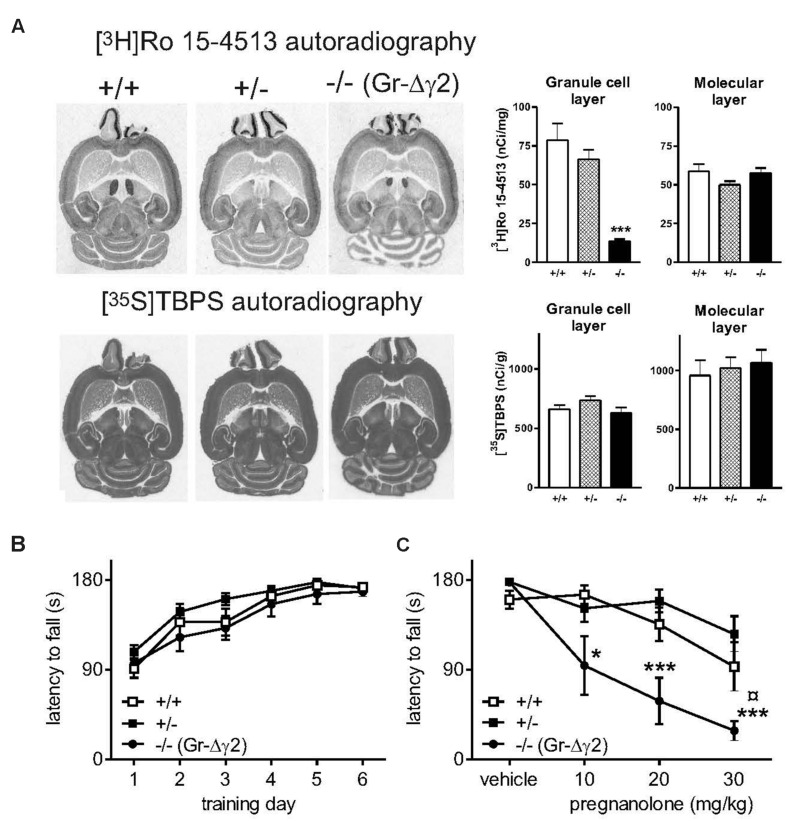
Neurosteroid sensitivity of Gr-Δγ2 mice with targeted inactivation of GABAA receptor γ2 subunit gene in the cerebellar granule cells. (A) Ligand binding sites in horizontal brain sections from Gr-Δγ2 mice with the wildtype γ2 subunit background. [3H]Ro 15-4513 labels the γ2 subunit-dependent flumazenil-sensitive benzodiazepine sites, which are deficient in the cerebellar granule cell layer of the genetically engineered mice, but not in the molecular layer (as shown in the bar graph). [35S]TBPS labels the picrotoxin-sensitive ionophore sites of the GABAA receptor, and this labeling is intact in the cerebellum of the genetically engineered mice, suggesting normal amounts of α and β subunit expression. (B) Rotarod learning. The rotarod was accelerated from 5 to 30 rpm during 180 s. Data for wild-type +/+ (n = 5), heterozygous +/- (n = 10) and Gr-Δγ2 knockout -/- (n = 6) mice are presented as daily means of 6 trials ± SEM. There were no significant differences between mouse lines. (C) Effects of pregnanolone on rotarod performance. Pregnanolone was administered in cumulative doses (10+10+10 mg/kg i.p., total 30 mg/kg) to the same animals, and the performance tested, as in panel (B). ANOVA followed by Newman–Keuls post hoc tests: ¤P < 0.05 for the significance of the difference of +/+ and +/- mice from the -/- mice. ∗P < 0.05, ∗∗∗P < 0.001 for the significance of the difference compared to vehicle within lines. Data are presented as means ± SEM.